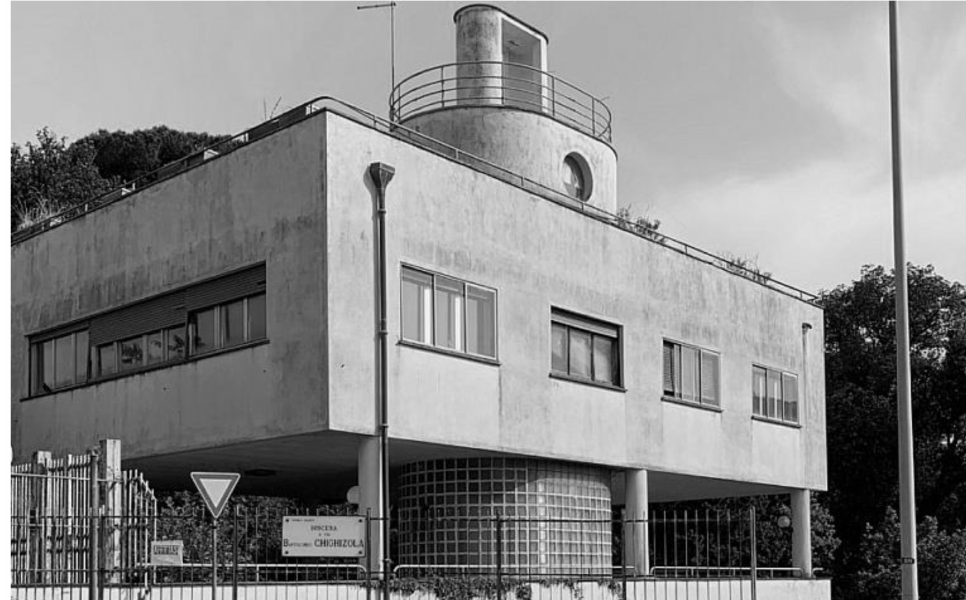
Figure 5. A view of the case study, the Casa Littoria Nicola Bonservizi, from the street above (source: https://partnership.ilgiornaledellarchitettura.com/2019/04/19/genova-per-la-casa-littoria- di-sturla-si-ricomincia-da-zero/, accessed on 23 March 2023 © Andrea